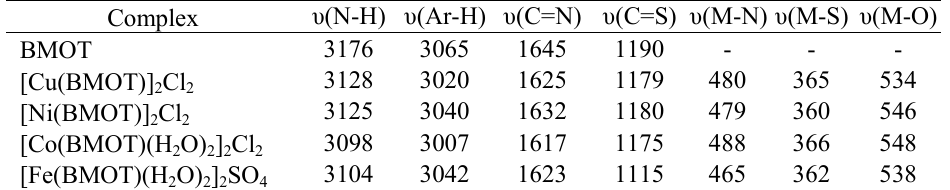
Table 3. Selective I.R. bands, cm -1 with tentative